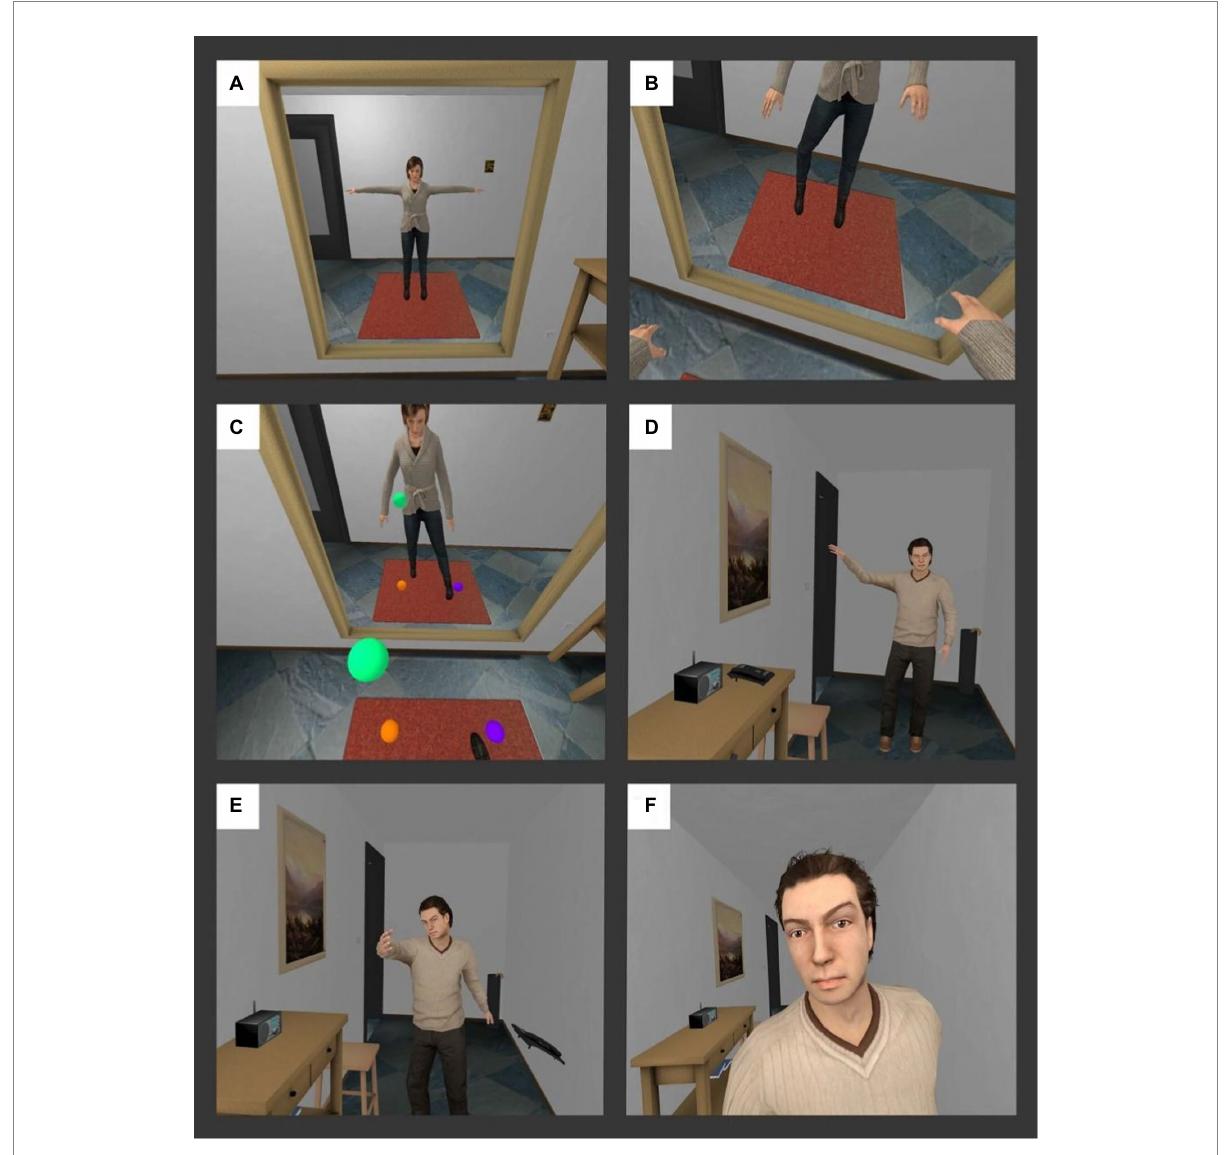
FIGURE 4 Virtual contents of a scene of intimate partner violence used in Seinfeld et al. (2018). (A) The male participant is embodied as a woman by moving his body and having correct sensorimotor correlations, while seeing the virtual body in the mirror. (B) The participant’s movements are applied to the virtual body. (C) The participant has a task to touch the virtual balls so that they move and see their virtual body movements both directly and in the mirror. (D) The male character enters the scene and starts to criticize the participant. (E) He pushes a telephone from the counter onto the floor while screaming at the participant. (F) He invades the space of the participant. Source: Seinfeld et al. (2018) (CC-BY